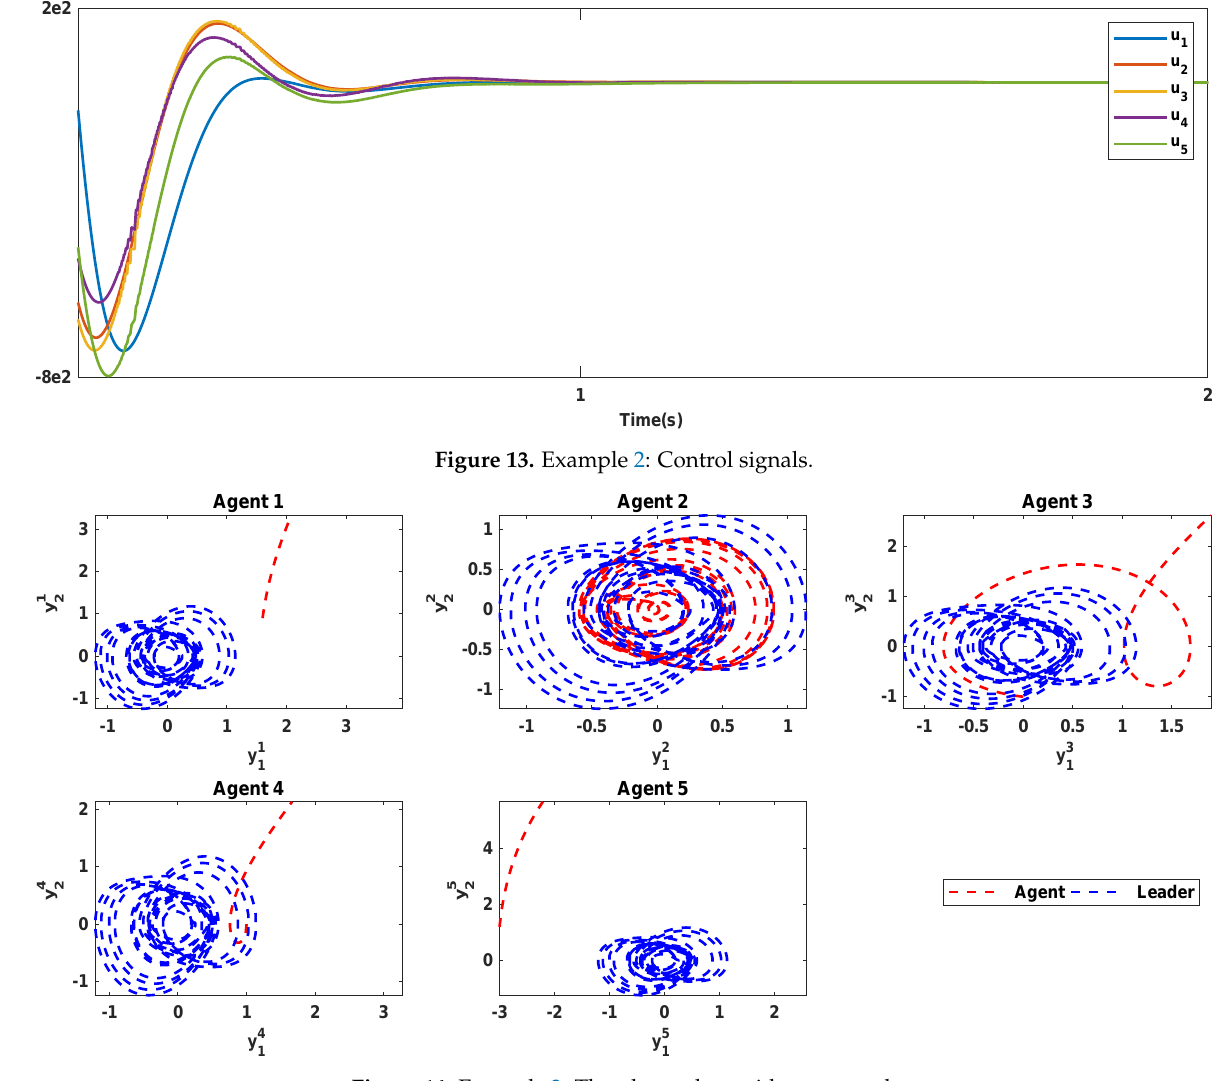
Figure 14. Example 2: The phase plan; without control.